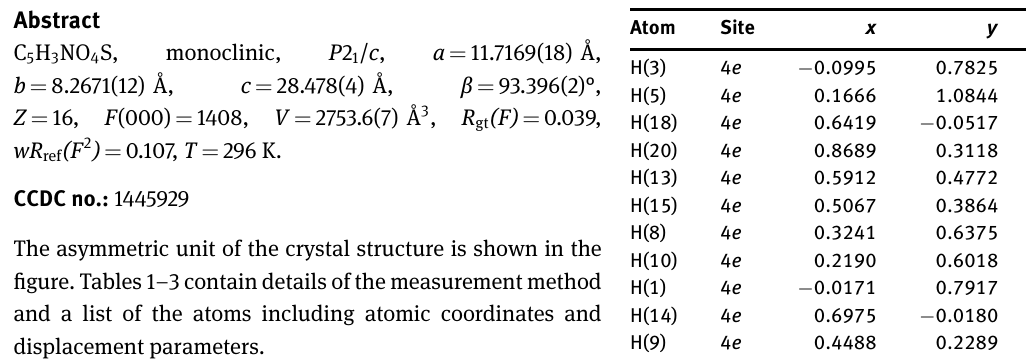
Table 2: Fractional atomic coordinates and isotropic or equivalent isotropic displacement parameters (Å 2